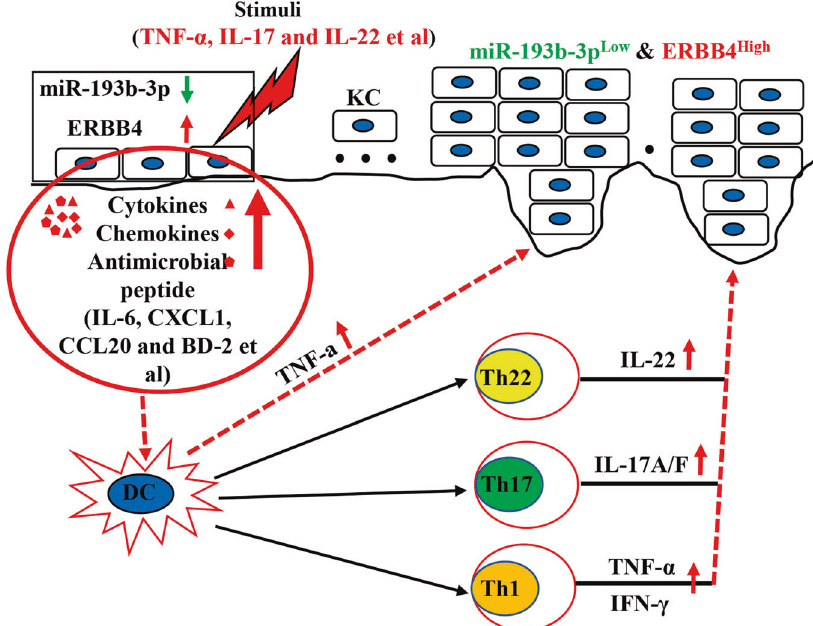
Fig. 9 Schematic diagram of MiR-193b-3p/ERBB4 axis involved in the pathogenesis of psoriasis. When keratinocytes are in a psoriasis- related in fl ammatory environment (or are subjected to external stimuli), the expression of miR-193b-3p is downregulated, while that of ERBB4 is upregulated. ERBB4 promotes the proliferation and expression of in fl ammatory genes ( IL-6 , CXCL1 , CCL20 , BD-2 , etc.) in keratinocytes, leading to the activation of keratinocytes and resulting in the recruitment and activation of relevant immune cells (including Th1, Th17, Th22, etc.). The activated immune cells secrete pro-in fl ammatory mediators (TNF- α , IL-17, IL-22, etc.), which further cause the downregulation of miR-193b-3p (ERBB4 is upregulated) in keratinocytes, forming a feedback loop and leading to the expansion of the in fl ammatory response in